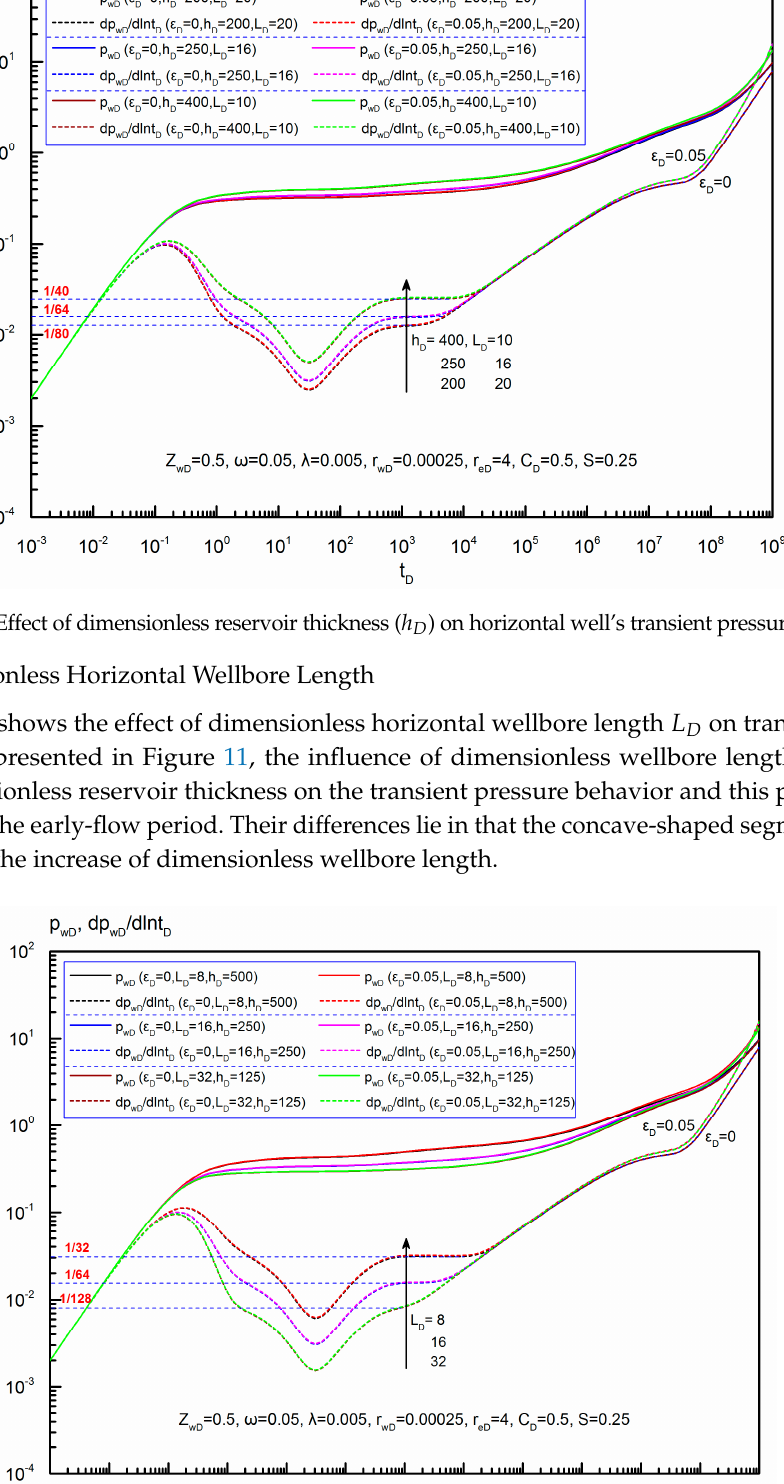
Figure 11. Effect of dimensionless wellbore length ( L D ) on horizontal well’s transient pressure behavior.